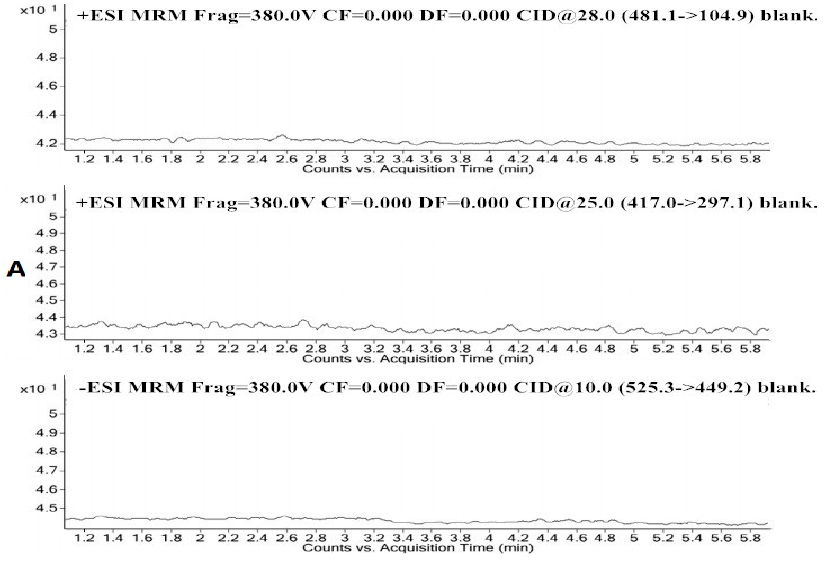
Figure 2 . Cont . Figure 2.